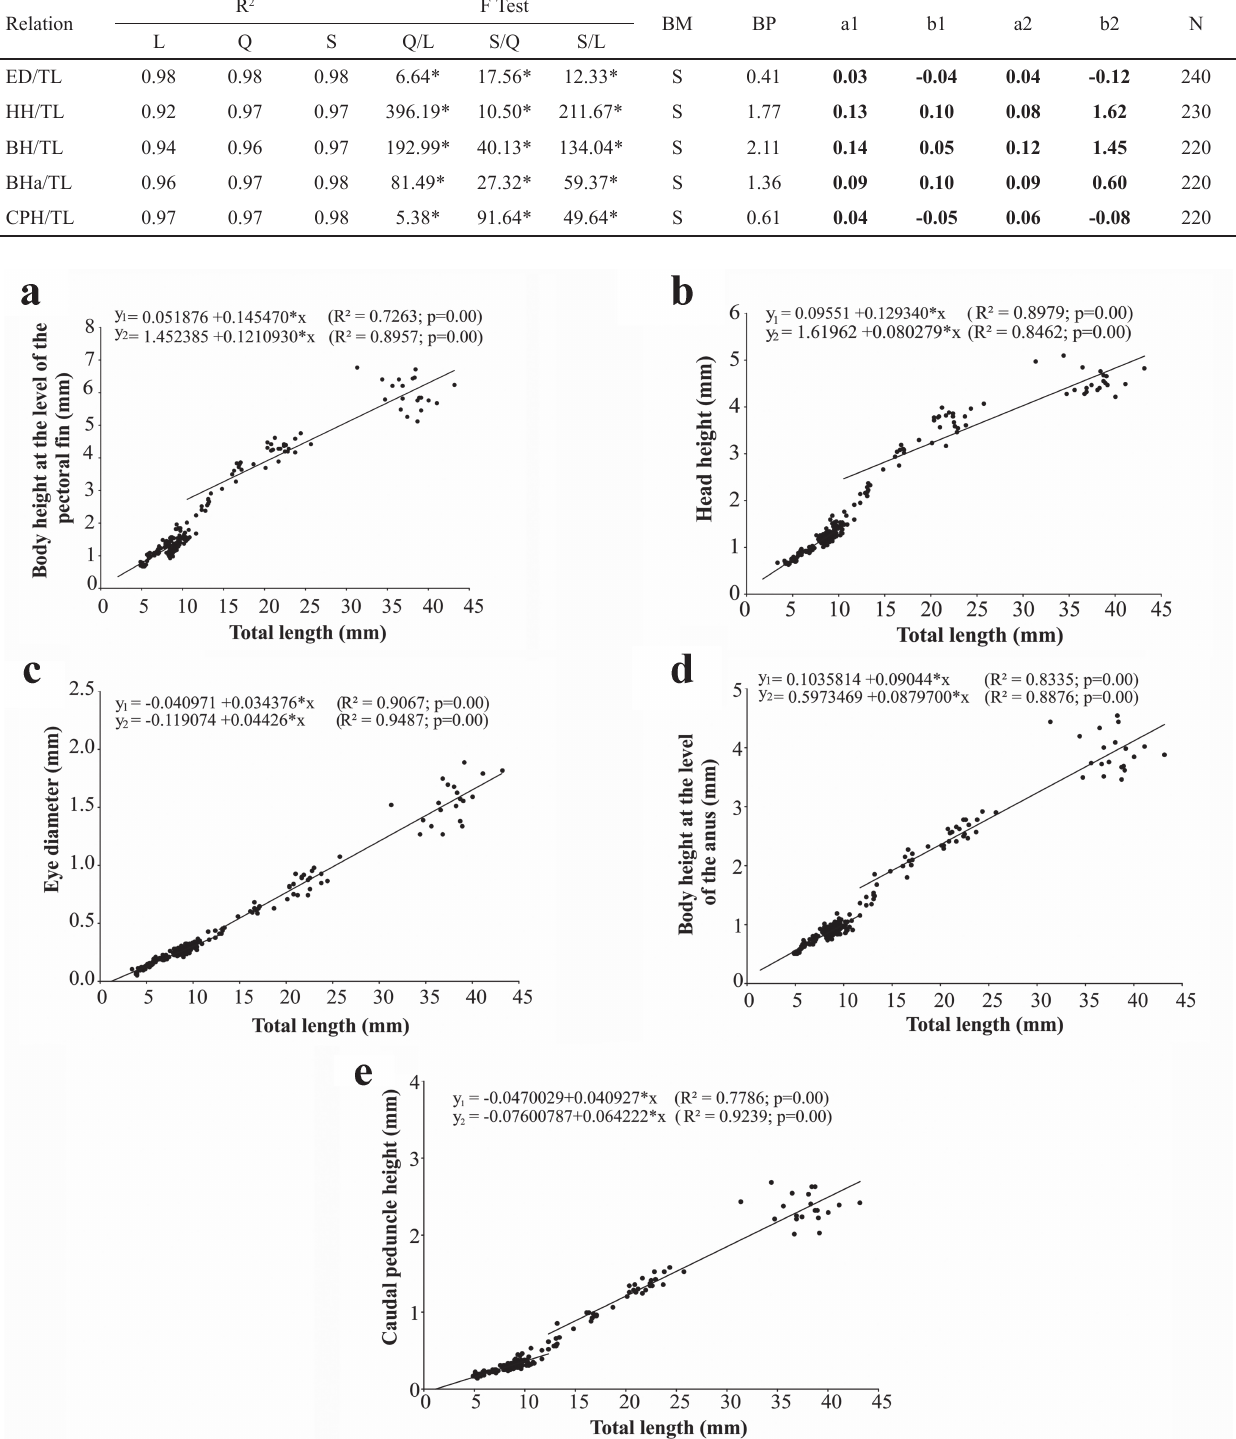
Fig. 6. Allometric growth of the body parts in relation to the total length during the development of Pseudoplatystoma reticulatum